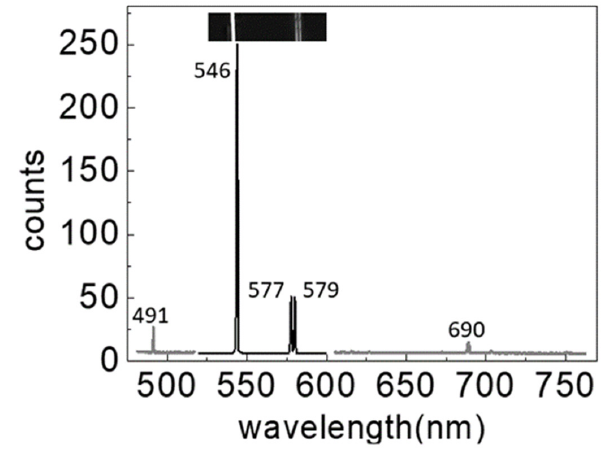
Figure 2. The inset shows a photo of the mercury lamp spectral lines, in which three bright lines appear at 546, 577, and 579 nm. The characteristic spectral lines of the mercury lamp in terms of wavelength are converted by interpolation. The darker portion in the middle is obtained with an exposure time of 1/125 s, and the gray portions on the two sides are obtained with an exposure time of 1/15 s. The spectral lines at 577 and 579 nm are distinguishable, showing that the resolution is less than 2 nm.